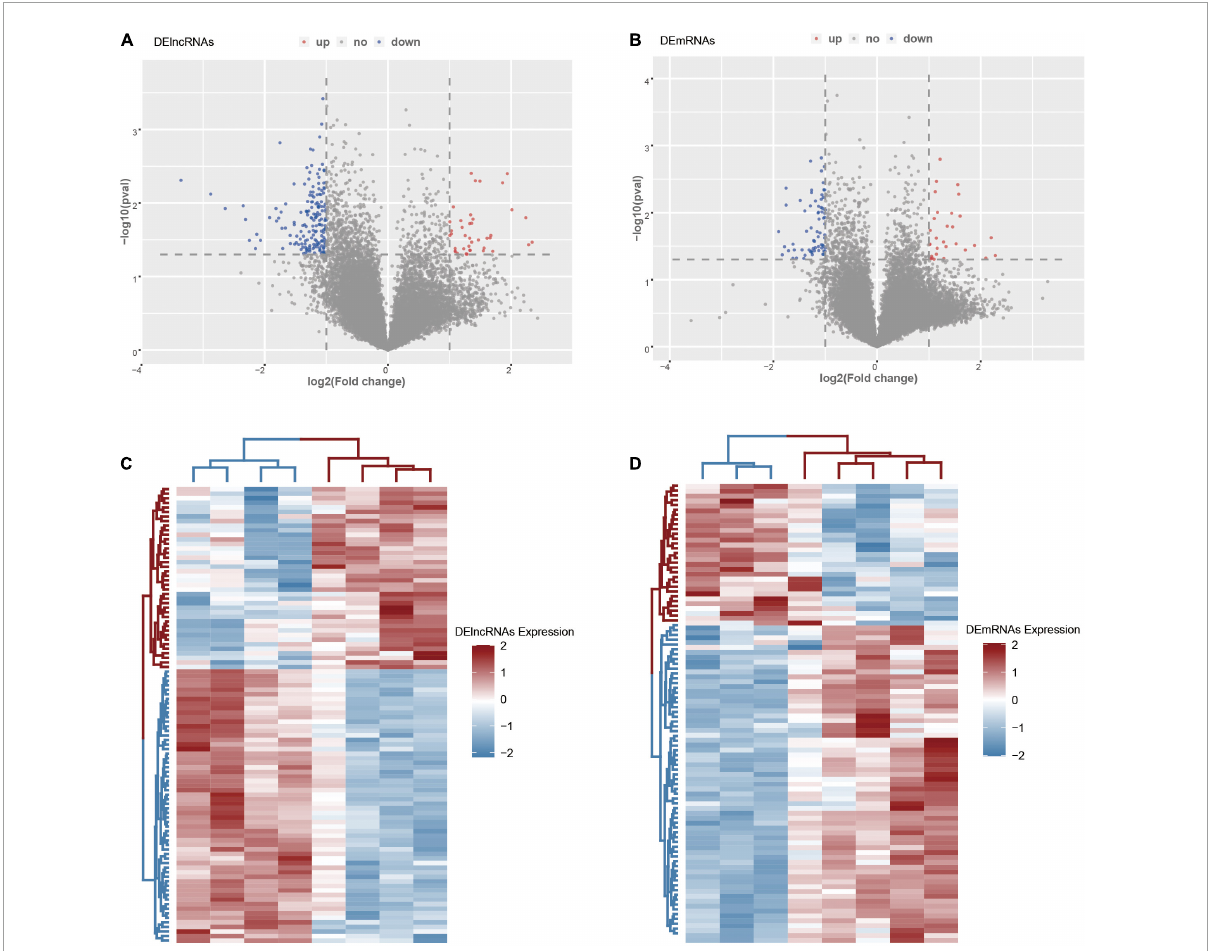
FIGURE2 The DElncRNAs and DEmRNAs in the ICH group compared with the control group. (A) The volcano map of DElncRNAs in the ICH group compared with the control group. (B) The volcano map of DEmRNAs in the ICH group compared with the control group. (C) The heat map of the top 100 DElncRNAs in the ICH group compared with the control group. (D) The heat map of DEmRNAs in the ICH group compared with the control group. Red represented up-regulation and high expression, while blue represented down-regulation and low